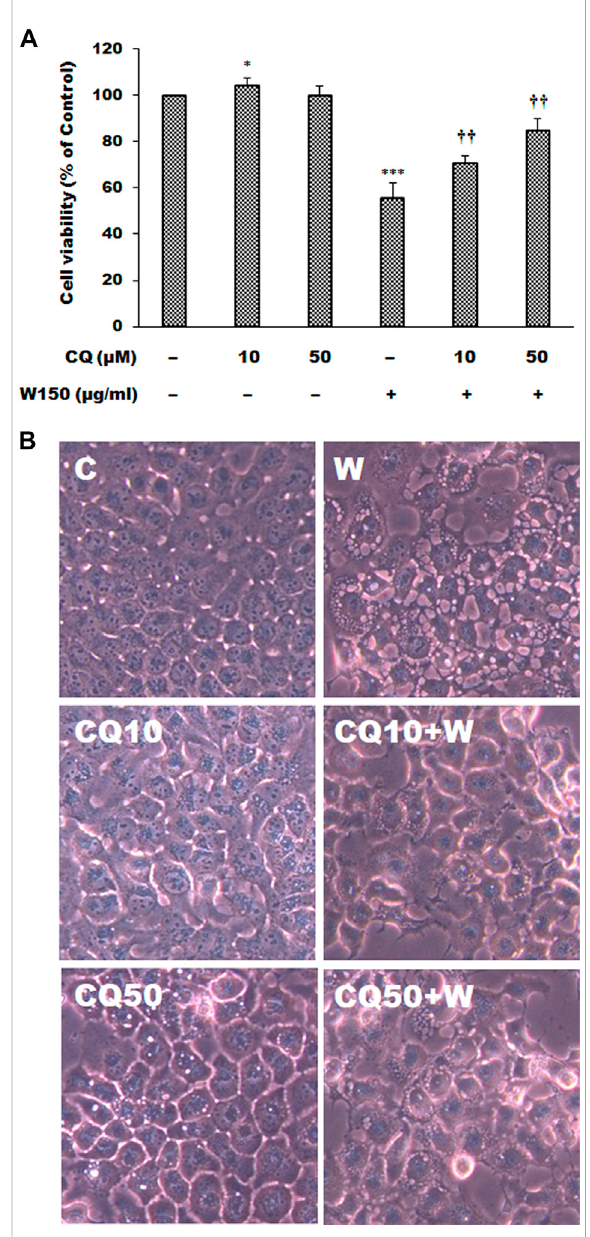
FIGURE 6 Theeffectsof chloroquine onWGMextracts-inducedcell death and membrane-enclosed vacuoles of Hep3B cells. Cells were pretreatedwith10or50 μ Mchloroquine(CQ)for1 handthentreated with 0.1% DMSO or 150 μ g/ml WGM extracts (W) for 24 h. (A) The effects of chloroquine on WGM extracts-induced cell death of Hep3B cells. After treatment, the viable cells were measured by MTT assay.Alldeterminationsareexpressedasthemean%control±S.D.of duplicate from three independent experiments. * p < 0.05, *** p < 0.001 compared to the control values. †† p < 0.01 compared to